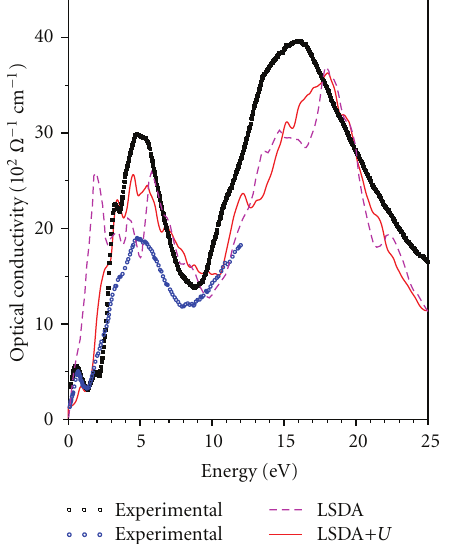
Figure 6: The absorptive part of the diagonal optical conductivity of Fe 3 O 4 calculated in LSDA (dashed line) and LSDA+ U (solid line) approximations [10] compared with experimental data [141] (solid squares) and [140] (open circles).